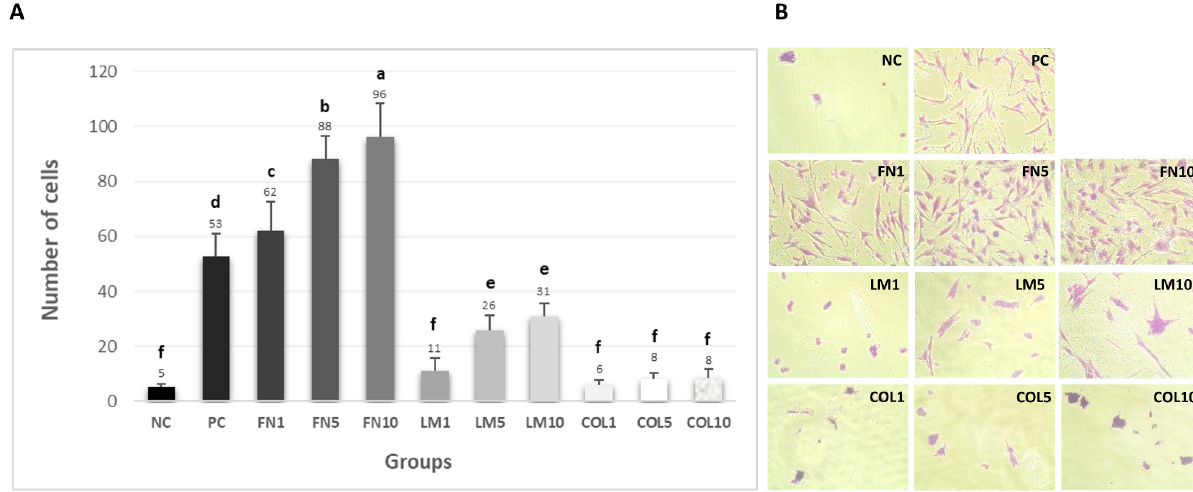
Figure 2- Cell adhesion assay. (A) Mean and standard deviation of the number of cells adhered to the bottom plate treated according to the group. Different letters demonstrate a significant difference between groups (n=6; one-way ANOVA/Tukey tests; α =0.05). (B) Representative images of the cell